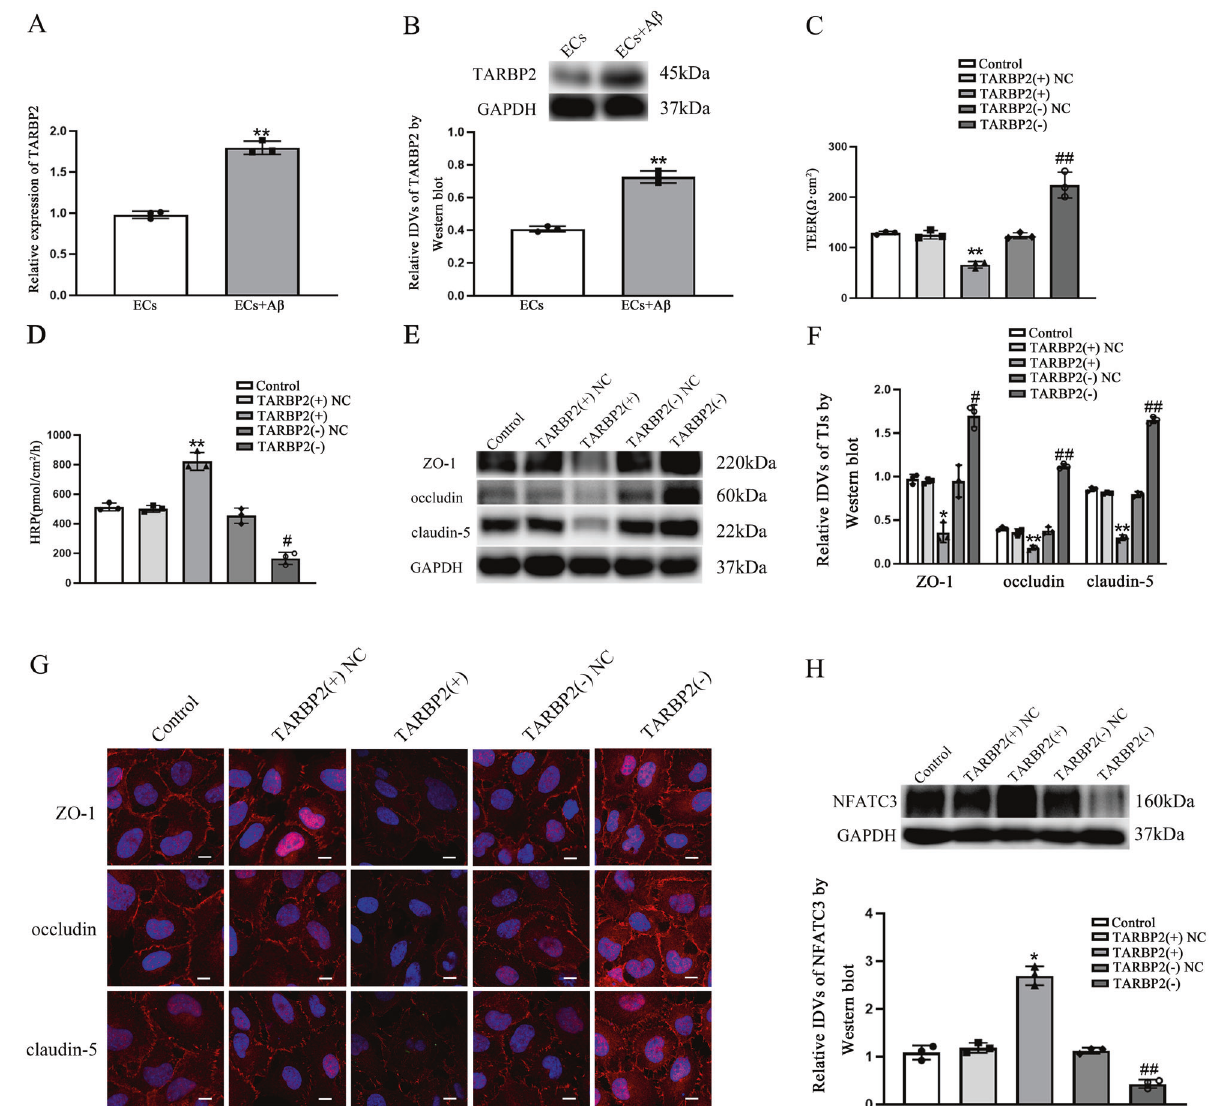
Fig. 2 Up-regulated TARBP2 increased BBB permeability in A β (1 – 42)-incubated ECs. A , B Relative expression of TARBP2 in ECs and A β (1 – 42)-incubated ECs was detected by qRT-PCR and western blot. **p < 0.01 vs. ECs group, data were presented as mean ± SD ( n = 3, each). C TEER values of BBB were presented as Ω cm 2 . **p < 0.01 vs. TARBP2( + )NC group. ## p < 0.01 vs. TARBP2( − )NC group, data were presented as mean ± SD ( n = 3, each). D HRP fl ux was calculated as pmol/cm 2 /h. **p < 0.01 vs. TARBP2( + )NC group. # p < 0.05 vs. TARBP2( − )NC group, data were presented as mean ± SD ( n = 3, each). E , F The relative expression levels of ZO-1, occludin and claudin-5 were measured via western blot. GAPDH was used as an internal control. *p < 0.05 and **p < 0.01 vs. TARBP2( + ) NC group. # p < 0 . 05 and ## p < 0.01 vs. TARBP2( − )NC group, data were presented as mean ± SD ( n = 3, each). G Immuno fl uorescence assay was performed to observe distribution of ZO-1, occludin and claudin-5 in ECs boundaries. ZO-1, occludin and claudin-5 were red. Nuclei were blue. Scale bar = 15 µm ( n = 3, each). H The relative expression level of NFATC3 was measured via western blot. GAPDH was used as an internal control. *p < 0.05 vs. TARBP2( + ) NC group. ## p < 0.01 vs. TARBP2( − )NC group, data were presented as mean ± SD ( n = 3,